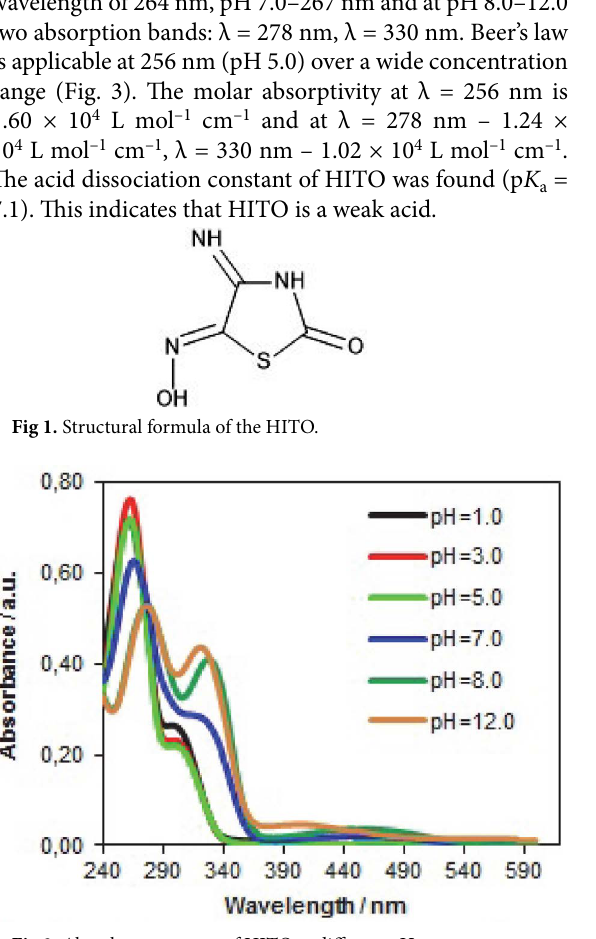
Fig 2. Absorbance spectra of HITO at different pH.